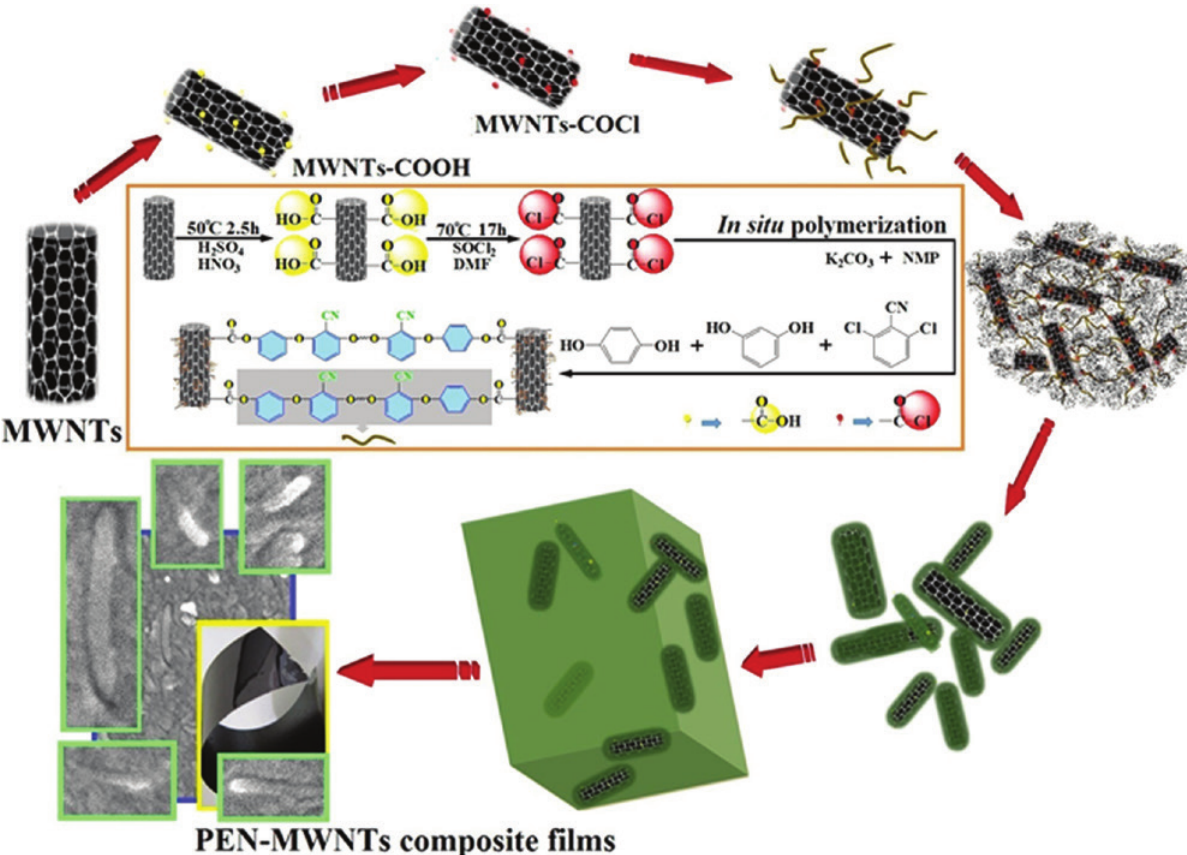
Figure 1: Schematic illustration of the preparation of PEN-MWNT composite